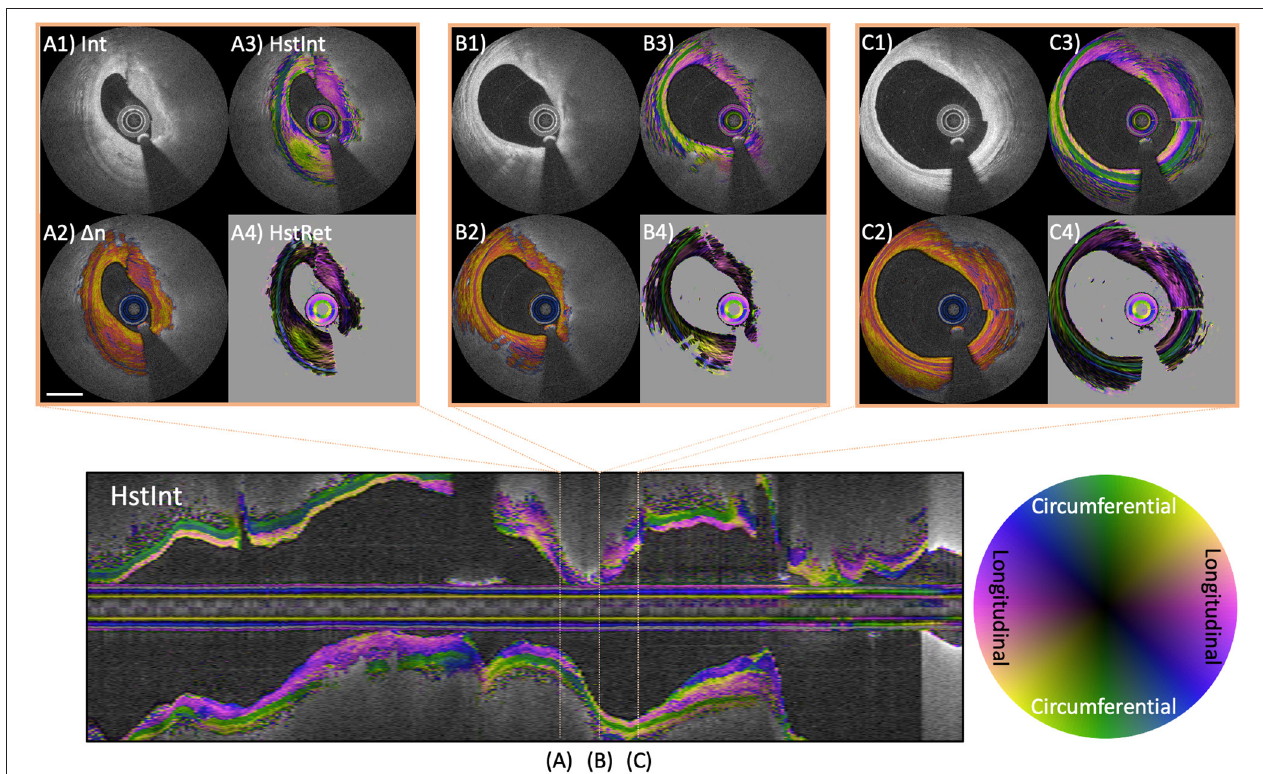
FIGURE 8 | Optic axis orientation in coronary atherosclerotic lesion. Longitudinal image displays the optic axis orientation overlaid on intensity of a coronary artery in a patient with stable angina pectoris. Color indicates axis orientation and brightness specifies intensity. (A–C) Three individual cross-sections, showing conventional intensity (A1,B1,C1) , birefringence (A2,B2,C2) , and depth-resolved optic axis overlaid on intensity (A3,B3,C3) or birefringence (A4,B4,C4) . The tunica media features green color, indicating circumferential orientation. (A3,A4) Heterogeneous optic axis orientation of the intimal fibrous tissue. The fibrous cap in (B3,B4) and fibrous areas in (C3,C4) feature longitudinal orientation of the optic axis. Scale bar indicates